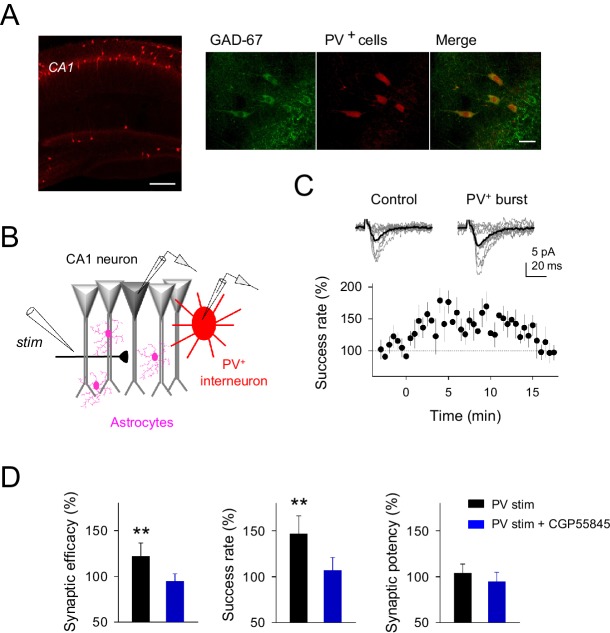
Parvoalbumin-positive CA1 interneuron stimulation potentiates excitatory synaptic transmission at single CA3-CA1 synapses.(A) Left, confocal image of hippocampus from a Pvalb-cre/Ai9-rcl-tdTomato mouse. Scale bar, 800 μm. Right, immunostaining for GAD-67 expressing interneurons in the CA1 hippocampal region. Note the colocalization of GAD-67 labeling (green) and PV+-tomato cells (red), indicating the GABAergic nature of PV+ neurons. Scale bar, 30 μm. (B) Scheme depicting paired recordings from PV+-interneuron (red) and CA1 pyramidal cells (gray), Schaffer collateral stimulating electrode (stim), and surrounding astrocytes (pink). (C) Top, synaptic responses evoked by minimal stimulation showing EPSC amplitudes and transmission failures (12 consecutive stimuli; light gray), and averaged EPSCs (40 consecutive stimuli; black) before and after PV+-cell APs bursting. Bottom, the time course of the success rate of neurotransmitter release before and after APs bursting of PV+-cell (n = 9; bin width, 30 s). Zero time indicates the onset of PV+-cell stimulation. (D) Relative changes of synaptic parameters from basal (white) elicited by pairing SC stimuli with bursts of PV+-cell APs (black), in control (n = 9) and in presence of CGP55845 (n = 5). **p<0.01; paired t-test. Error bars indicate SEM.